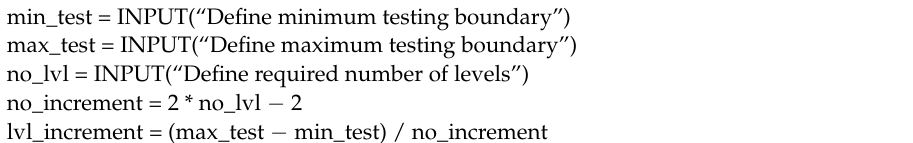
Algorithm 2 . Alternative algorithm for binning a given factor into desired number of factor levels in available data set according to desired testing